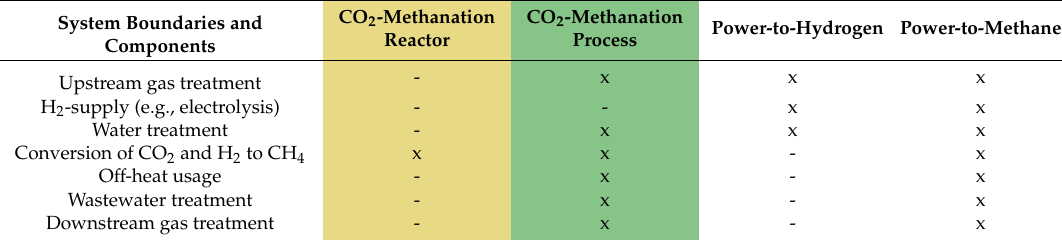
Figure 1. Boundaries and mass and energy streams of the systems CO 2 -Methanation reactor (yellow), CO 2 -Methanation process (green), Power-to-Hydrogen and Power-to-Methane. Table 2. Boundaries and components of the systems ‘CO 2 -Methanation reactor’, ‘CO 2 -Methanation process’, ‘Power-to-Hydrogen’ and ‘Power-to-Methane’. Background colors of the first two systems refer to the system boundary colors given in Figure 1.